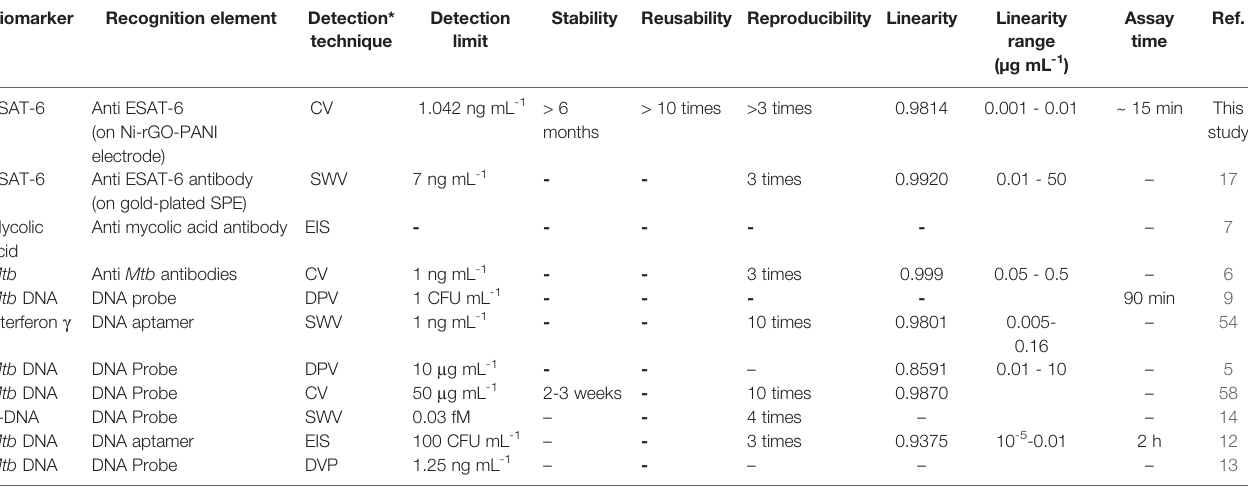
*SWV, square wave voltammetry; DPV, differential pulse voltammetry.